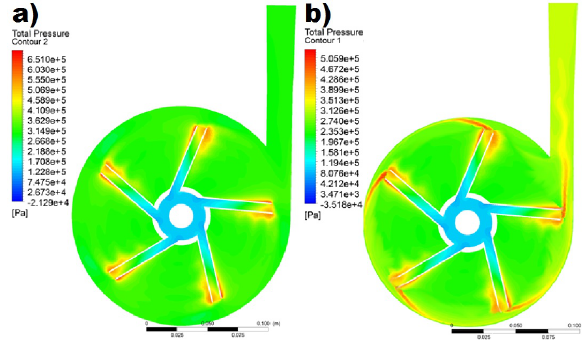
Figure 12: Distribution of total pressure on central plane (SPAN50) for: a) base model pump, b) pump with rational flow geometry of annular